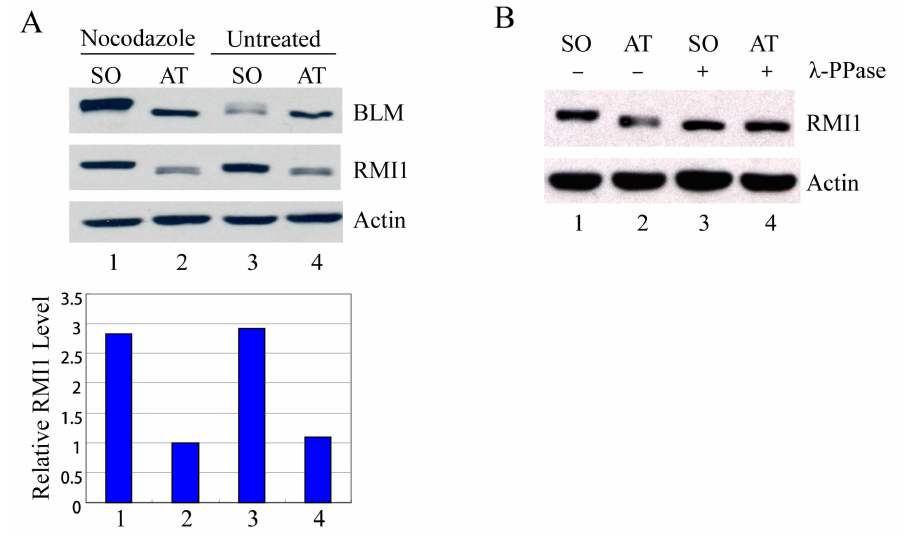
Figure 2. RMI1 accumulates and is phosphorylated in mitosis. ( A ) Mitotic cells were harvested by mechanical shake-off from the nocodazole-arrested HeLa cells and untreated asynchronous HeLa cells. Attached cells were considered as interphase cells. Upper panel: Total cell lysates were analyzed by Western blot; Lower panel: The relative RMI1 protein levels were calculated according to their densitometry readings, which were normalized by the corresponding Actin bands; ( B ) Nocodazole-treated cell lysates were subjected to the λ -phosphatase treatment or not. SO: shake-off cells; AT: attached cells. Numbers under the panels stand for the lane number.